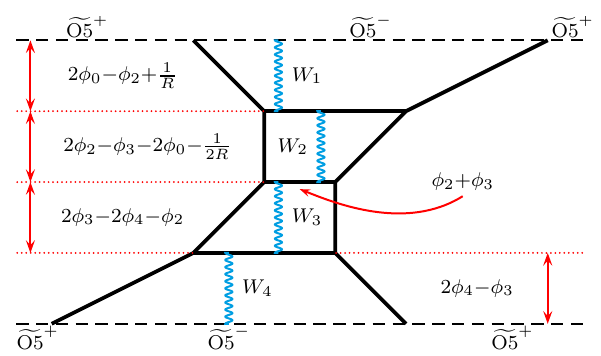
Figure 4. The 5-brane web of SO(8) theory with Z 2